Question: Give a one-sentence summary of this figure.
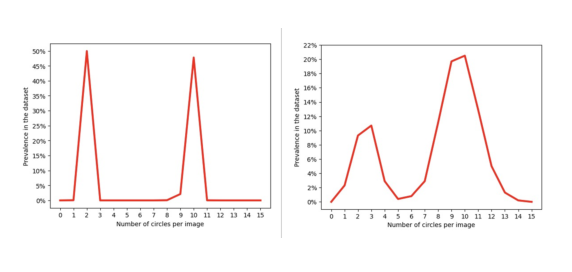
Answer: Distributions of circle occurrences in images using a stable diffusion model: (Left) Training dataset, specifically images containing either 2 or 10 circles; (Right) Distribution observed in the generated images.